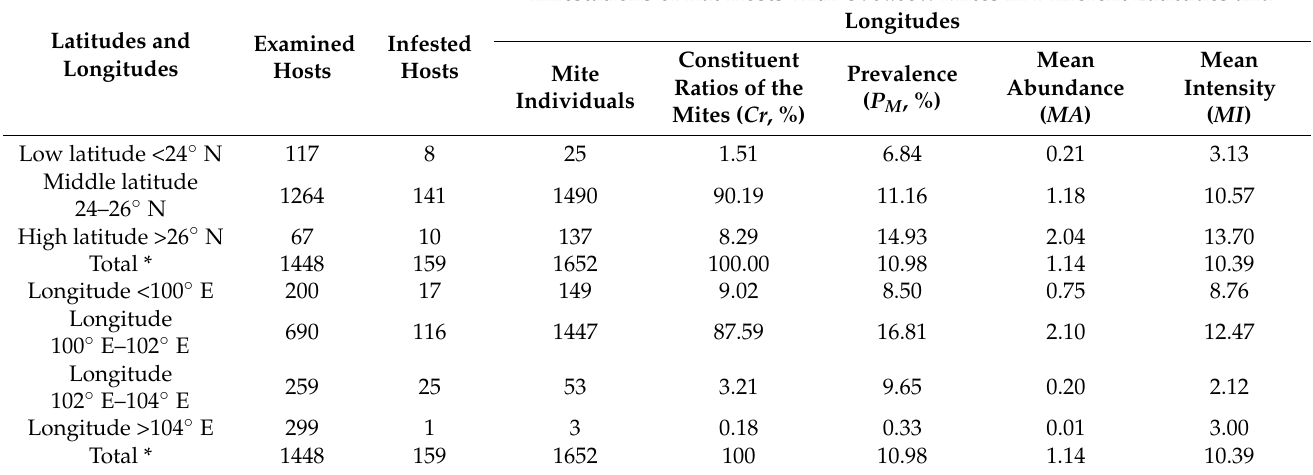
Table 5. Infestations of R. norvegicus rats with O. bacoti mites in different latitudes and longitudes of Yunnan Province, Southwest China (1990–2015).